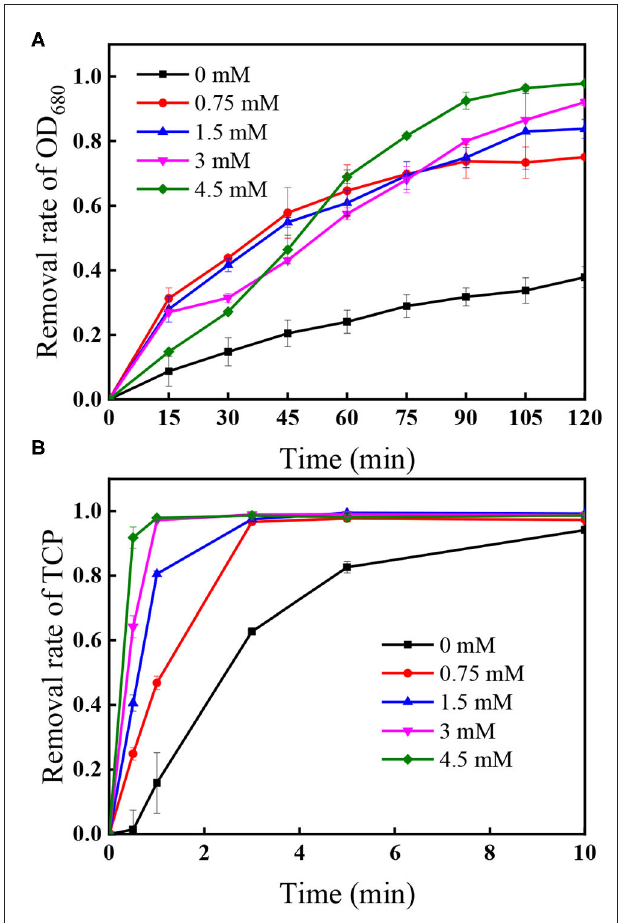
FIGURE 6 | Effect of UV intensity on the removal of (A) OD 680 and (B) TCP. Conditions: initial algal cell density: (1.00 ± 0.05) × 10 6 cells/mL, initial TCP concentration: 20 µ M, initial pH: 7.6 ± 0.2, temperature: 25 ± 1 ◦ C, PS dose: 1.5mM. The error bars represent the standard deviations from duplicate